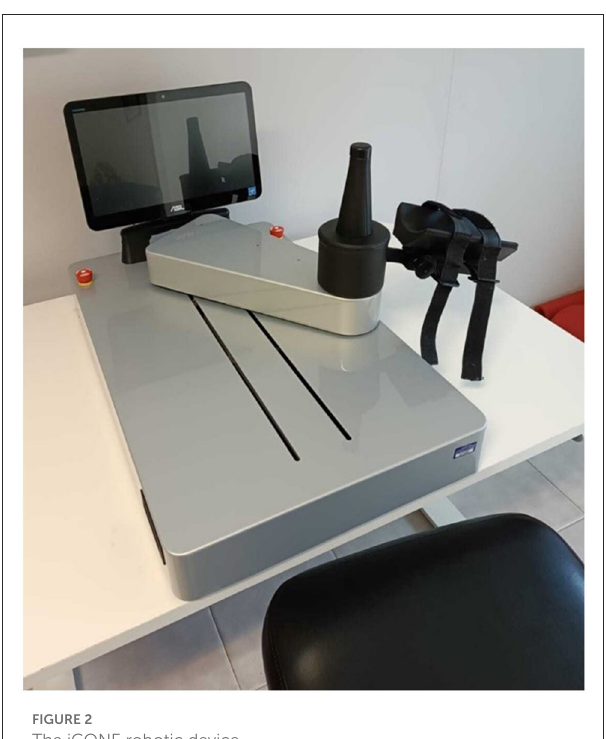
FIGURE2 The iCONE robotic device.